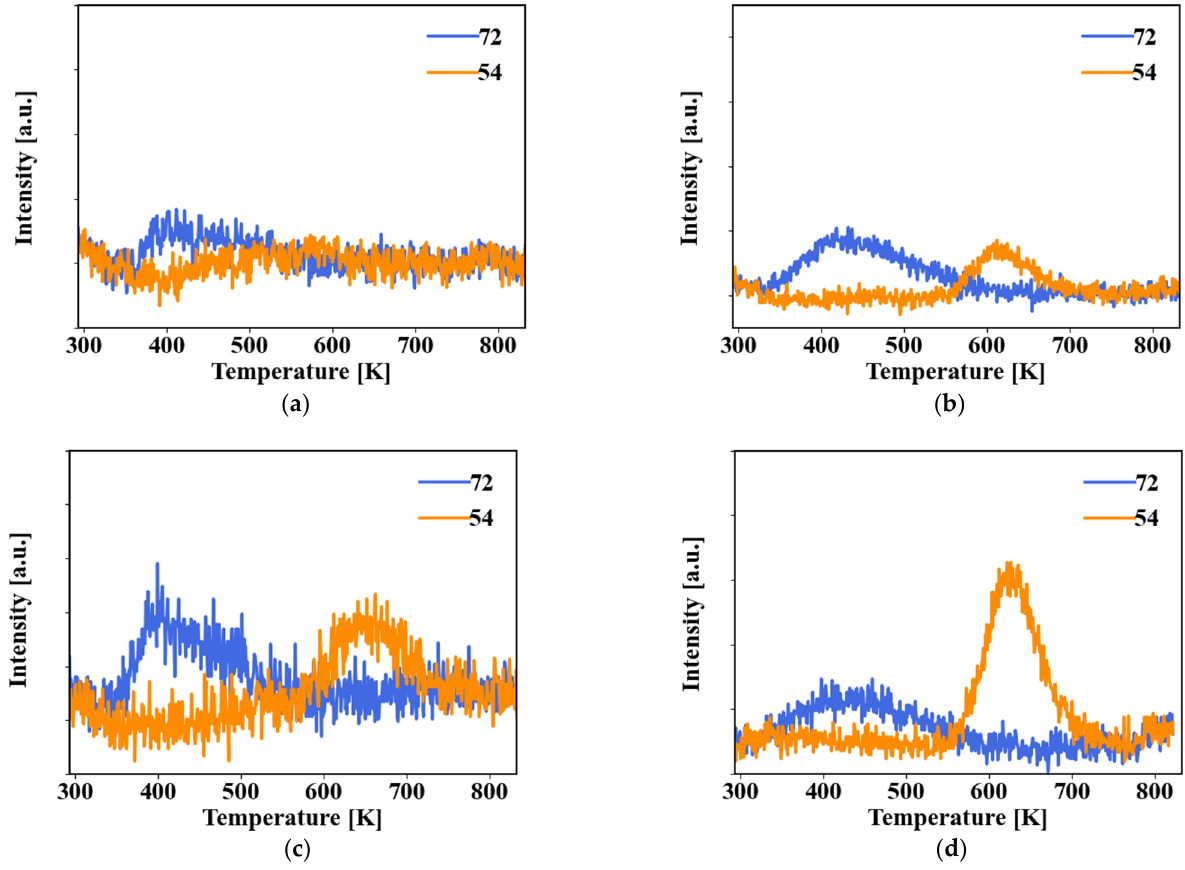
Figure 7. TPD data for THF-dosed ( a ) MAO; ( b ) 0.2 nm ZrO 2 -MAO; ( c ) 0.5 nm ZrO 2 -MAO; ( d ) 1 nm ZrO 2 -MAO. The m/e = 72 and 54 signals correspond to THF and 1,3-butadiene, respectively.